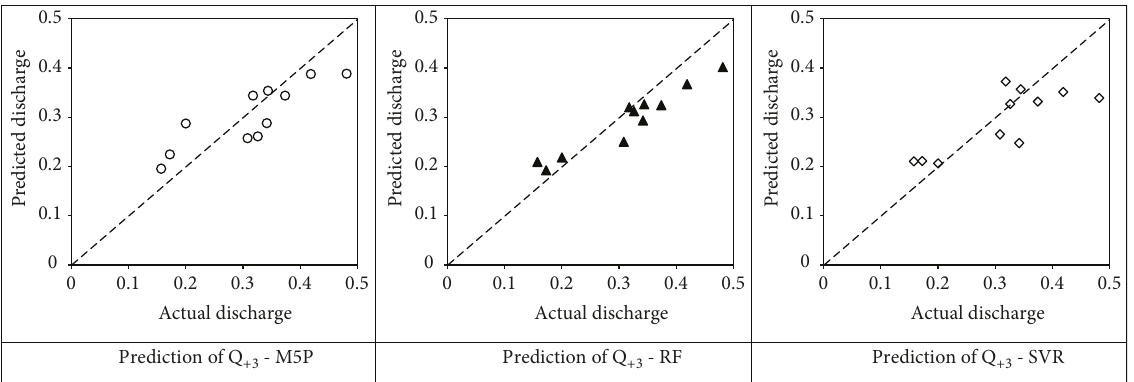
Figure 14: Comparison between predicted and observed discharges (m 3 /s), 4-month input.